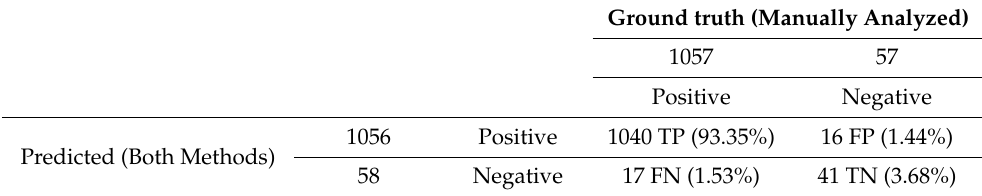
Table 4. Confusion matrix of the results obtained by the hybrid